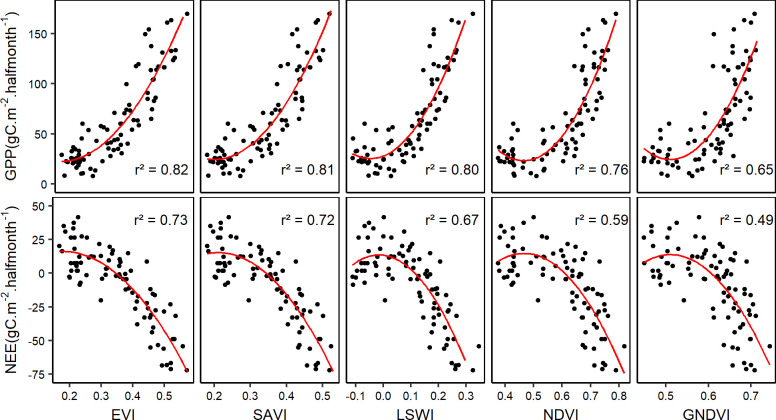
Empirical model fitting of fluxes with VI.The red lines represent quadratic regression lines fitted to the cloud of points (flux~VI).